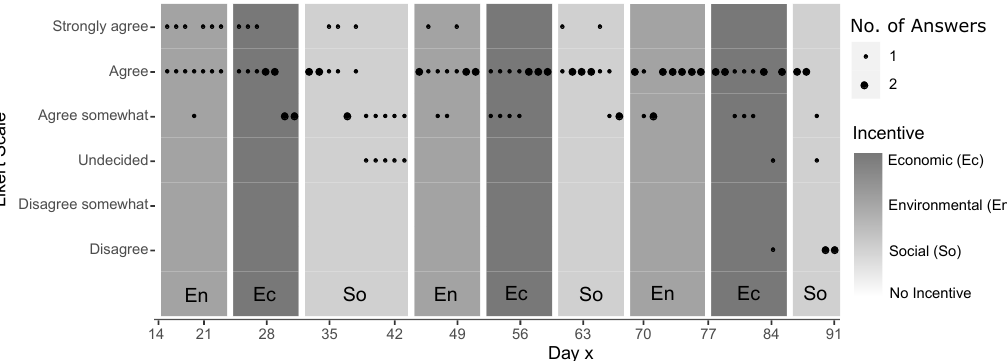
Figure 6. Self-assessment of the residents about their ability to perform the